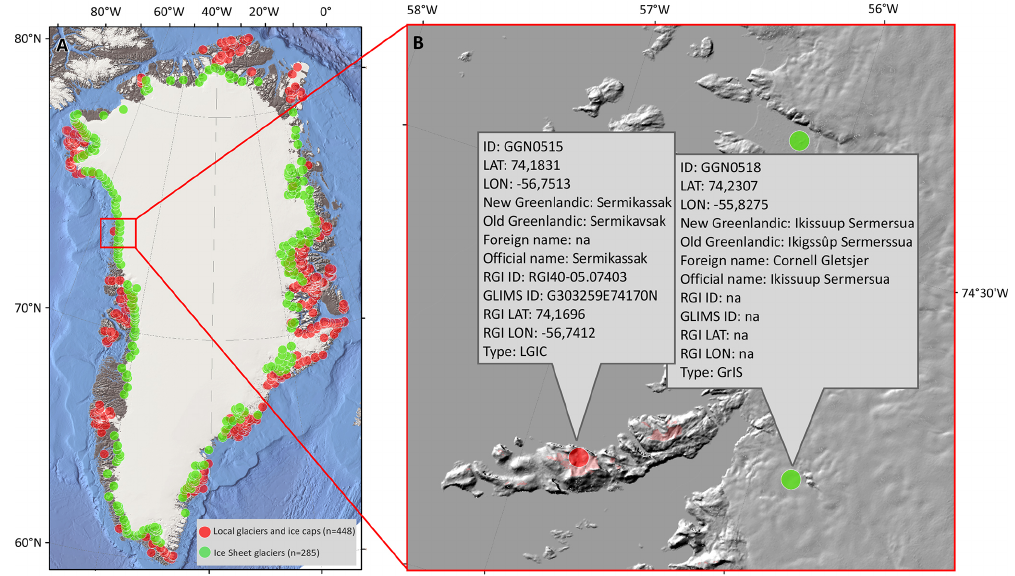
Figure 1. Distribution of official glacier names in Greenland and contents of new palace name data set. Local glaciers and ice caps (LGICs) are in green; glaciers from the Greenland Ice Sheet (GrIS) are in red. (a) The spatial concentration of glacier names is high in the populated areas and in areas that have been extensively explored – however, there are still fairly large stretches of coastline with no named glaciers (e.g., the southeast and north coasts). Background image: IBCAO ver3.0 (Jakobsson et al., 2012). (b) A zoom-in on the Melville Bay in northwest Greenland with examples of the contents of the new glacier name database. Background images are a GIMP hillshade (Howat et al., 2014).